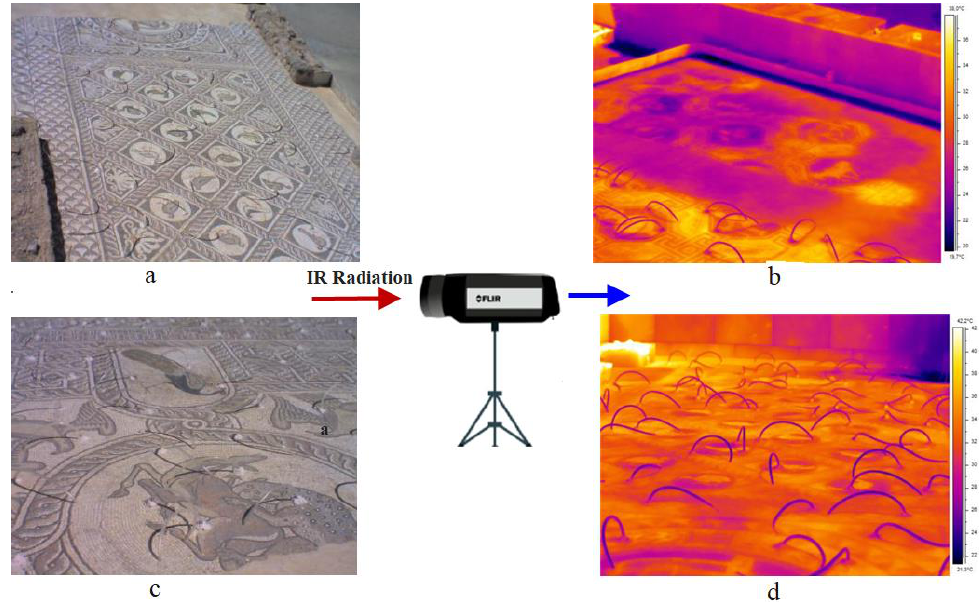
Figure 7. ( a ) Panoramic view of the Delphi floor mosaic’s eastern area, ( b ) representative thermal image without a drainage system, ( c ) mosaic area of animal representations on the tessellated layer, and ( d ) representative thermal image with the drainage system. (Reprinted under the terms of the Creative Commons Attribution 3.0 license from Ref. [77]).